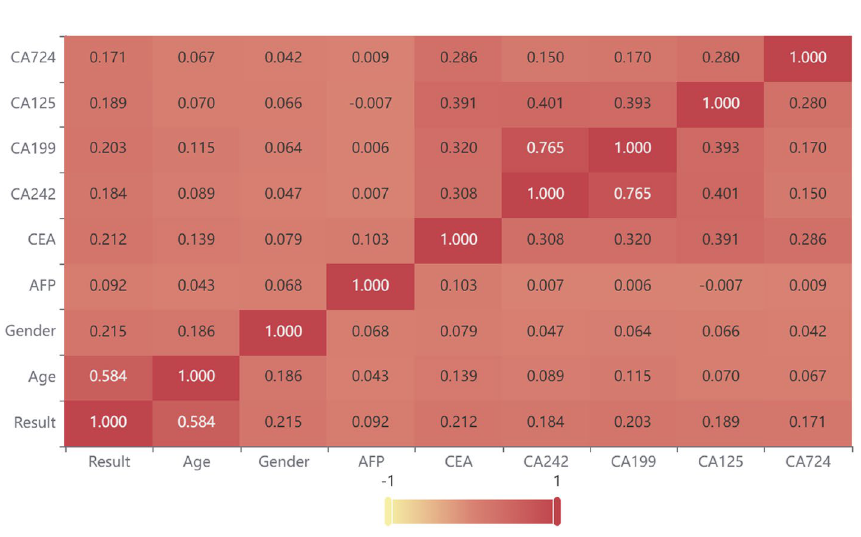
Figure 3. The heatmap showed the Pearson’s correlation coefficient of indicators (the heatmap was created using an online platform for statistical services, SPSSPRO, http:// www. spssp ro.